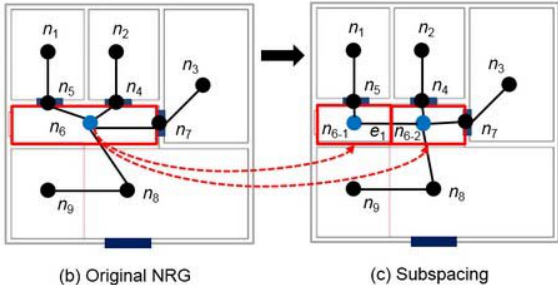
Figure 2. Subspacing method, (a) original NRG, (b) NRG